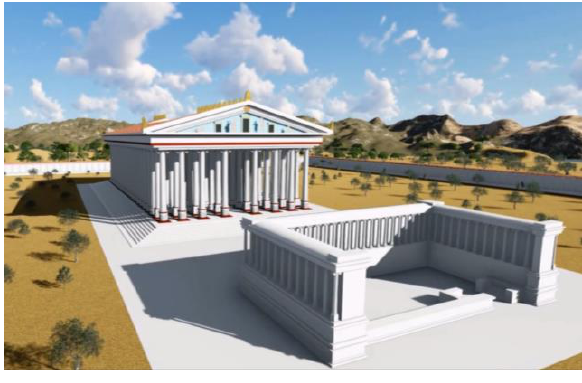
Figure 8. Reconstructed Classical Artemision